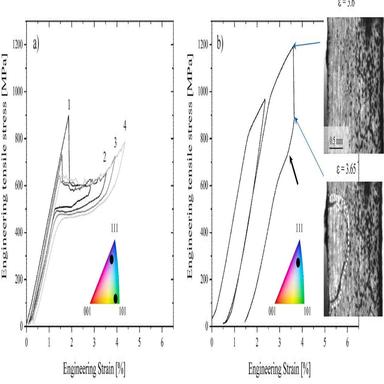
Engineering tensile stress vs. engineering strain hysteresis loops of two specimens with crystal orientations indicated in the stereographic standard triangle. (a) Oligocrystal with two grains of 〈111〉 and 〈110〉 orientation, respectively. (b) Single crystal with 〈111〉 orientation with crack formation during tensile loading (marked by dashed white line in the lower inset).